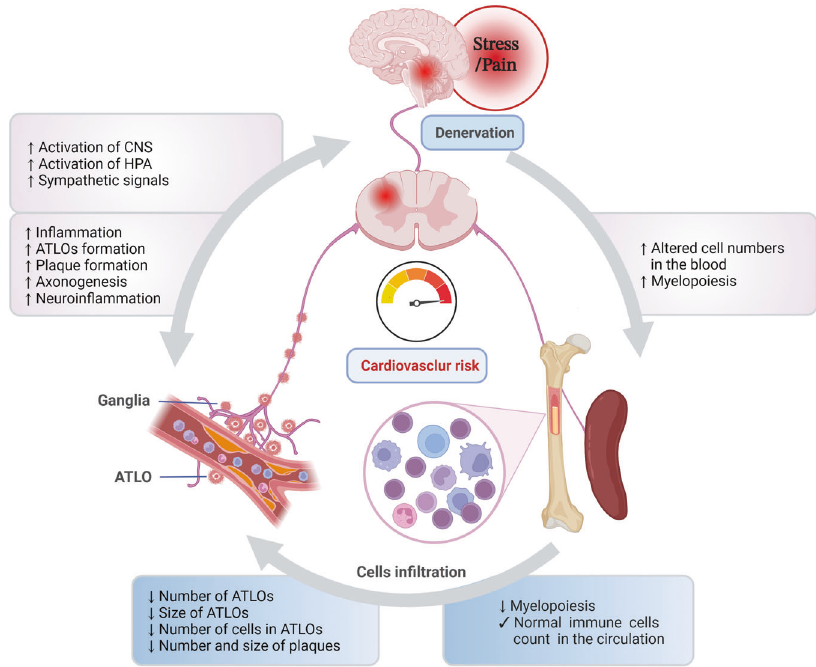
Fig. 1 Denervation attenuates atherosclerosis. Stress and pain may trigger atherosclerosis via activating the sympathetic nervous system (SNS) and hypothalamic-pituitary-adrenal (HPA) axis. Mental stress alters immune cell balance in the circulation and promotes myelopoiesis in the bone marrow and spleen. Activation of the SNS promotes artery-associated tertiary lymphoid organ (ATLO) formation and induces axonogenesis around adventitia adjacent to plaque segments. Sympathectomy and denervation reduces atherosclerosis by reducing the number, size, and cellularity of ATLOs as well as plaque formation (indicated by blue color). It also decreases in fi ltrating cells into the plaques and improves the hematopoietic stem cells pro fi le as well as circulating cell numbers. The fi gure was created with